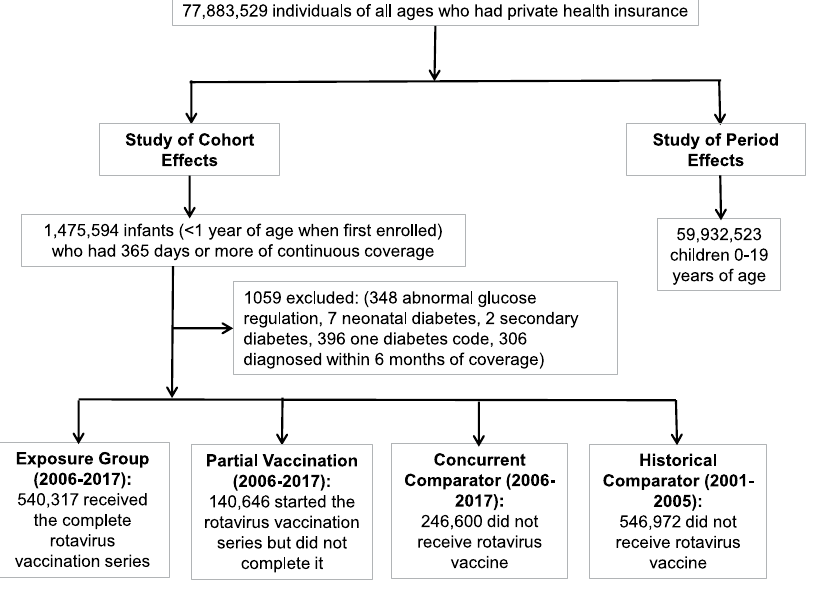
Figure 1. Flow Diagram of Study